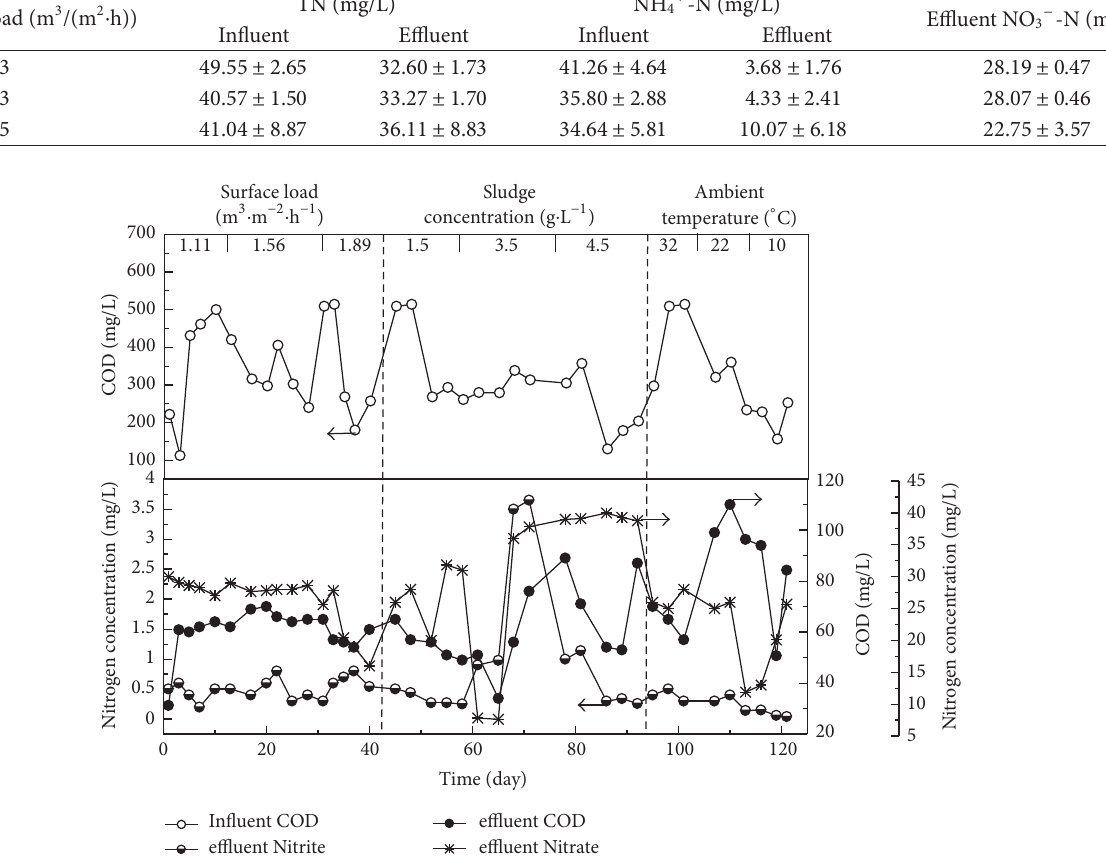
F 3: Effluent nitrate and nitrite concentrations and COD removal in a DSTR system.